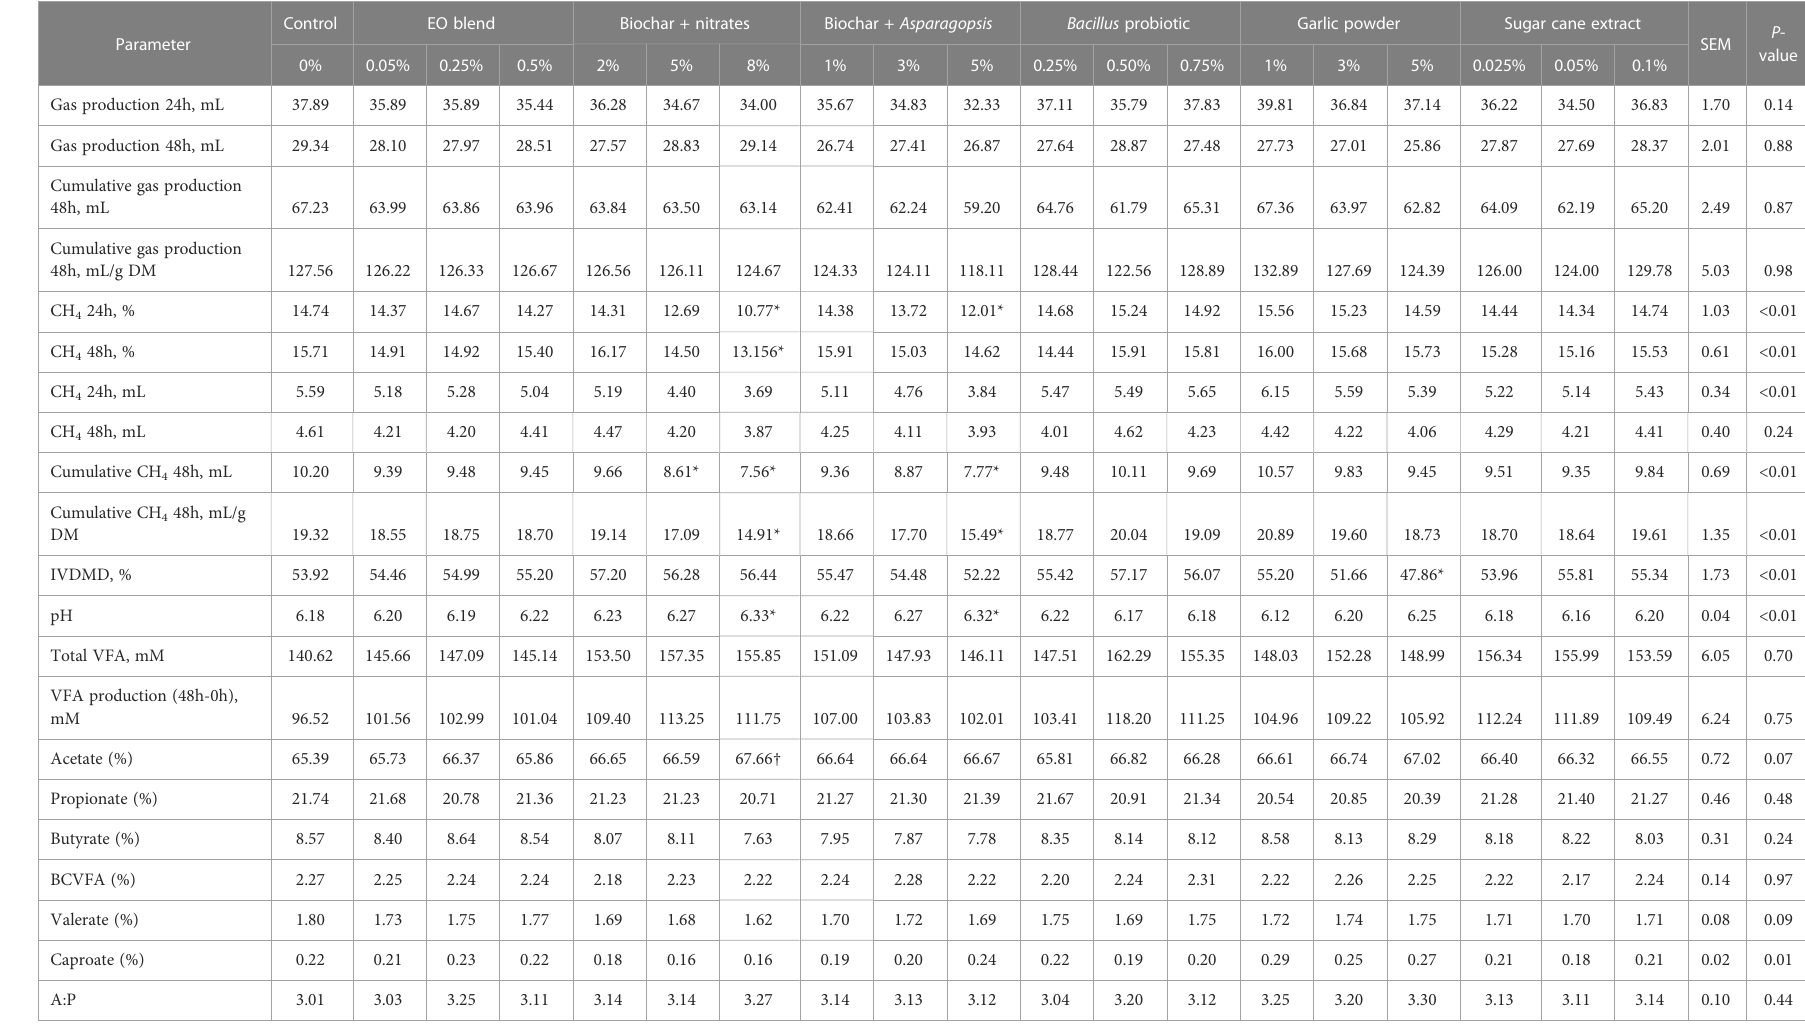
TABLE 4 Effects of powder additives (% DM) on rumen fermentation parameters, IVDMD and methane over 24 and 48 h of incubation, through three in vitro batch culture fermentation